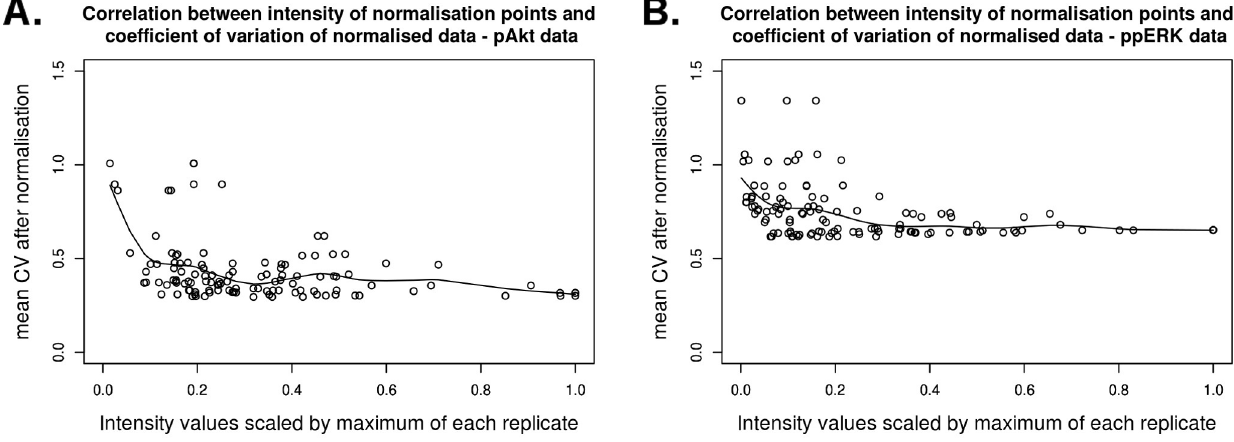
Figure 4. Correlation between the intensity of the normalisation points and the CV of the normalised data. Using data from (A) phosphorylated Akt and (B) phosphorylated ERK from Figure S3 in [25] (Figure S5 in this publication) we tested every point on a blot as normalisation point. For each resulting normalisation we computed the average of the CV of the normalised data points, and plotted the value of each data point (scaled so that the maximum of each replicate is equal to 1) against the average CV obtained by normalising with the corresponding data point. The result shows how the intensities of each normalisation point chosen correlate with the variability of the normalised data.